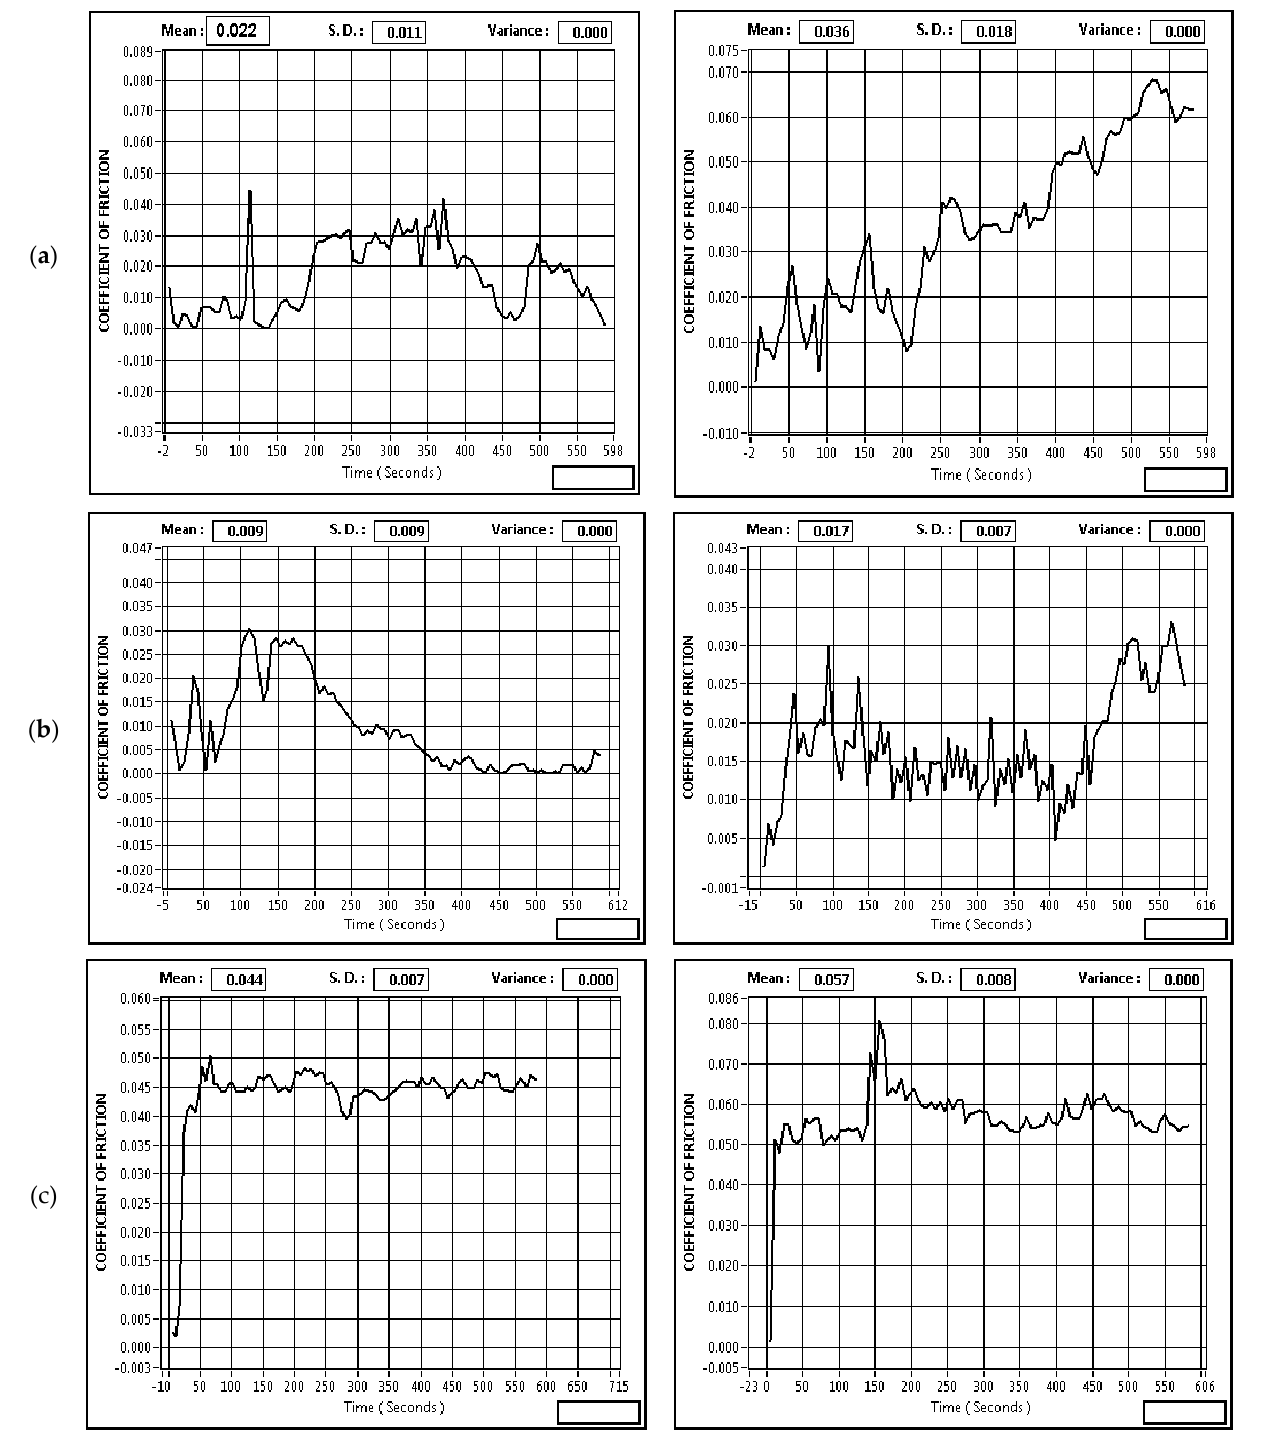
Figure 6. Coefficient of friction v/s time for CNT filled GFRP composites, during ( a ) dry sliding, ( b ) oil lubricated, and ( c ) argon sliding at 40 N, 120 N, at sliding speed 2.51 m/s and 1508 m.